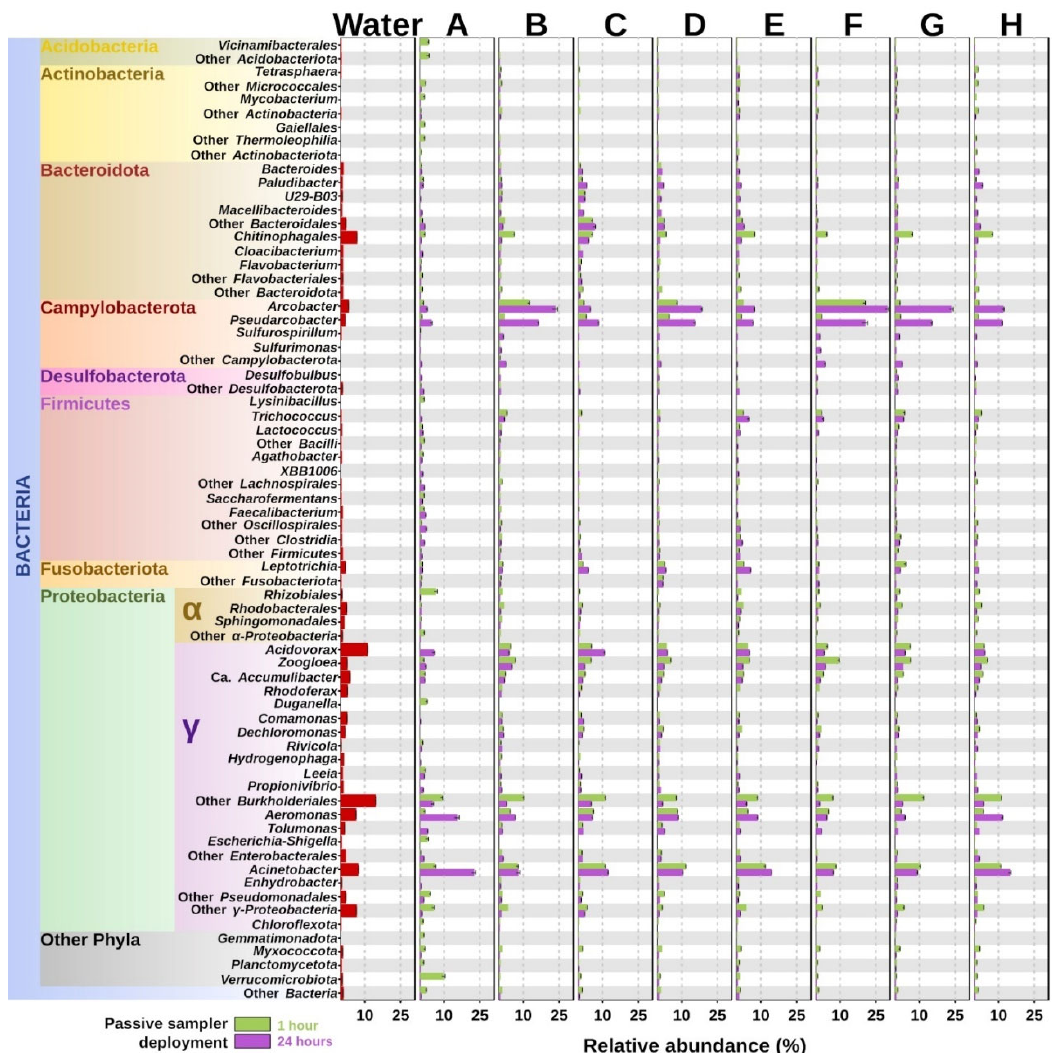
Figure 3. 16S rRNA bacterial diversity profile for eight different passive sampler materials (A to H) after deployment in the crude influent stream for either 1 or 24 h at a centralized wastewater treatment plant. The bacterial class profile for the three individual replicates for each sampler material are shown. The bacterial diversity of a composite sample of wastewater taken over the first hour of sampling is shown for reference at the left ‐ hand side.